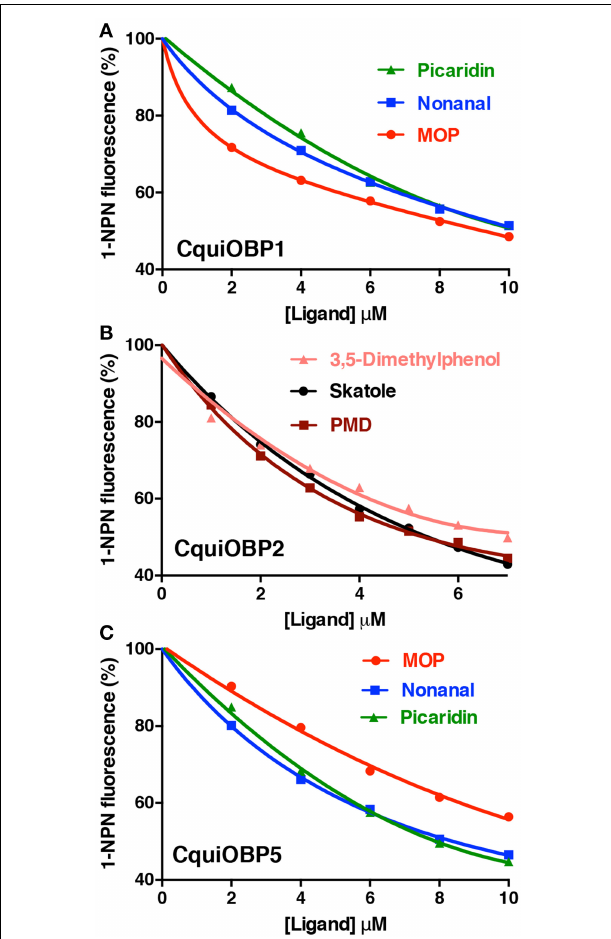
FIGURE 3 | pH-dependent quenching of fluorescence emission by CquiOBP1-bound NPN. All curves showed a truncated bell-shape curve, with minimal quenching at low pH and maximal quenching at high pH (6–7). Quenching decreased at pH values higher than 7, i.e., the pH expected for the sensillar lymph (Kaissling,